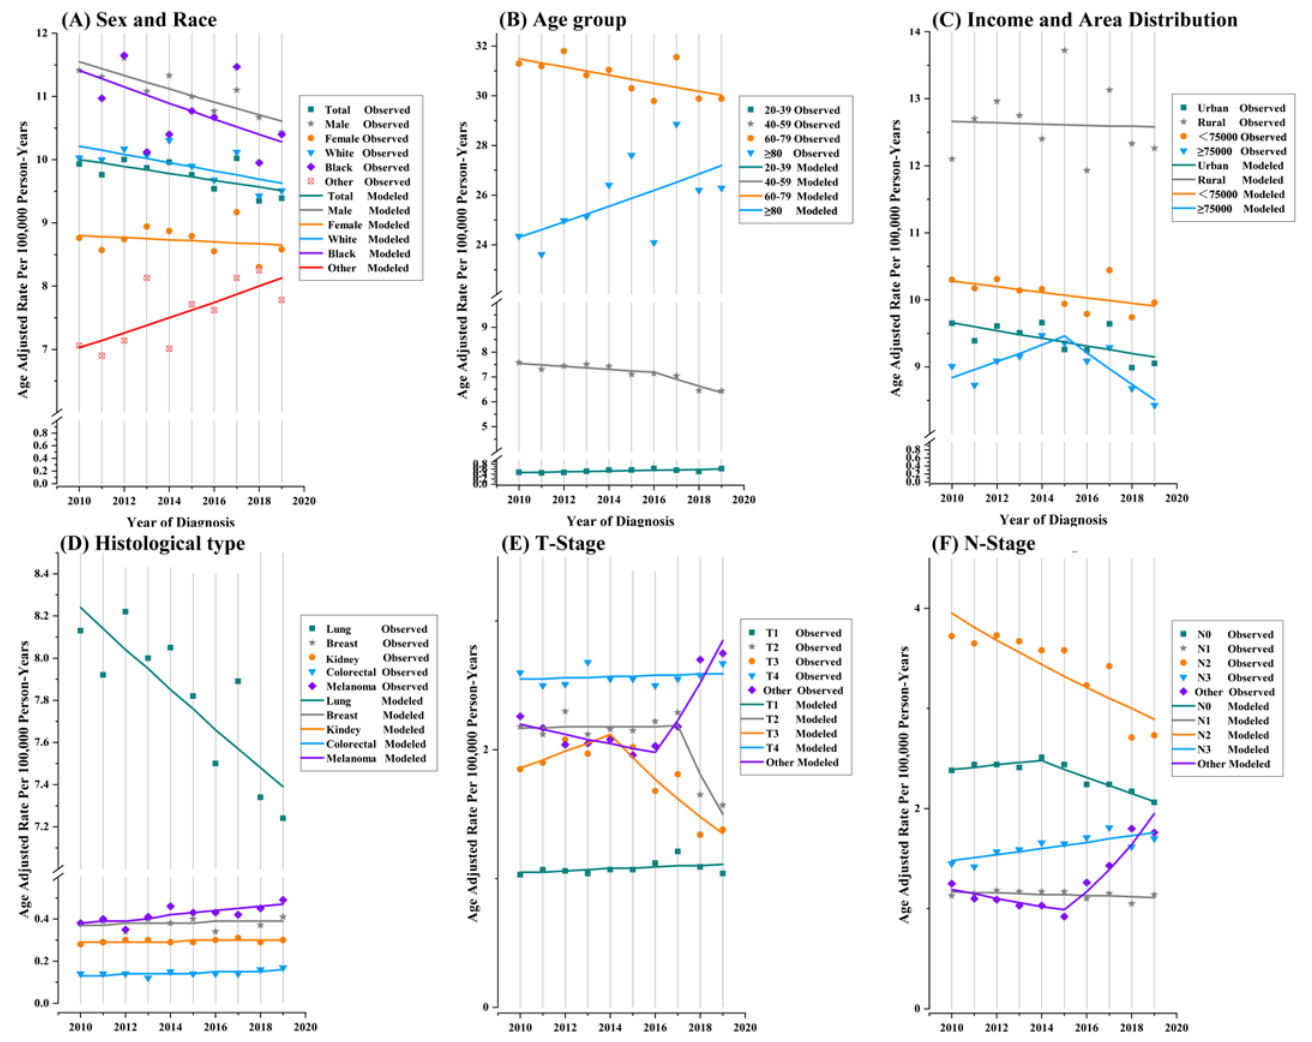
Figure 2. Trends in annual synchronous brain metastasis incidence rates by sex and race ( A ), age ( B ), median household income and area distribution ( C ), primary tumor site ( D ), T-Stage ( E ) and N-Stage ( F ). All rates presented were age-adjusted based on the 2000 U.S. standard population (cases per 100,000 person-years). Each segment on the line represents the annual percent change (APC). The joinpoint analysis revealed that SBM-incidence-based mortality rates increased sharply at a positive APC of 28.6% (95% CI, 19 to 38.9; p < 0.001) between 2010 and 2012 (Figure 3, Table 3). Contrastingly, they steadily declined with a negative APC of − 1.8 (95% CI, − 2.8 to − 0.8; p = 0.006) from 2012 to 2019. Similarly, a trend of first rising and then falling with a single joinpoint in 2012 was observed for both genders; white and black people, people aged 20–39, 40–59, and 60–79 years; both urban and rural-area patients; both low- and high-MHHI families; T1-, 2-, 3-, and T4-Stages; N0-, 1-, and N2-Stages; and patients with/without chemotherapy, with radiotherapy, and with/without surgical treatment. For SBM patients older than 80 years old, there was a rapid rise in incidence-based mortality rates (APC = 21.5; 95% CI, 5.4 to 40.2; p = 0.017), which then rose smoothly over time at an APC of 0.6% (95% CI, − 1.3 to 2.6; p = 0.432). Trends in incidence-based mortality rates among patients receiving no radiotherapy also showed a rapid rise, followed by a gradual increase (Table 3, Figure S1). Men died at an incidence-based mortality rate around 1.18 times higher (95% CI: 1.16 to 1.19) than women, and the value reached 1.39 (95% CI: 1.34 to 1.45) among those over 80 years old (Table S3). By primary tumor site of